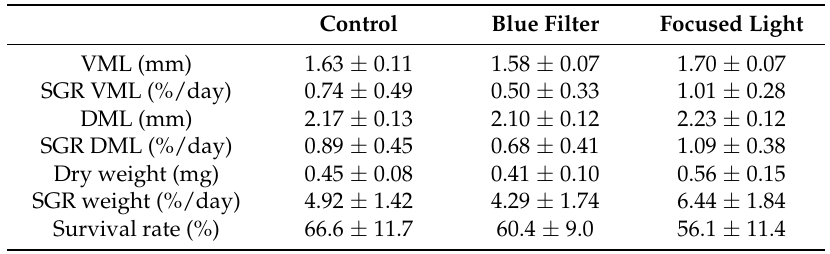
Table 2. Effect of different light conditions in O. vulgaris paralarvae growth and survival. Control Blue Filter